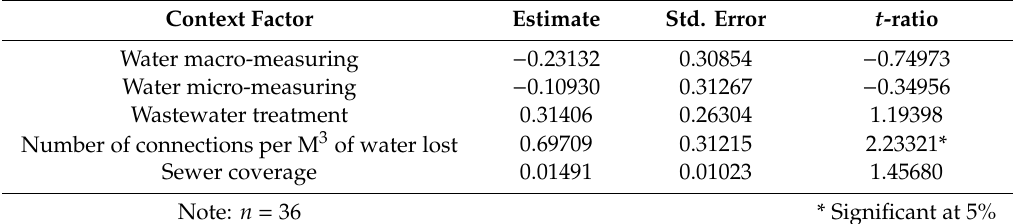
Table 11. Results of bootstrap truncated